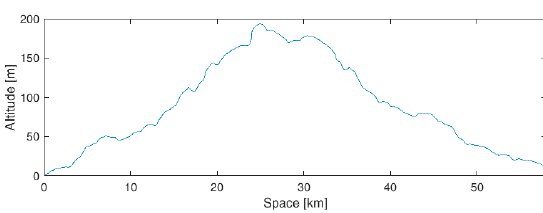
Figure 12. Extra-Urban 2 altitude profile.